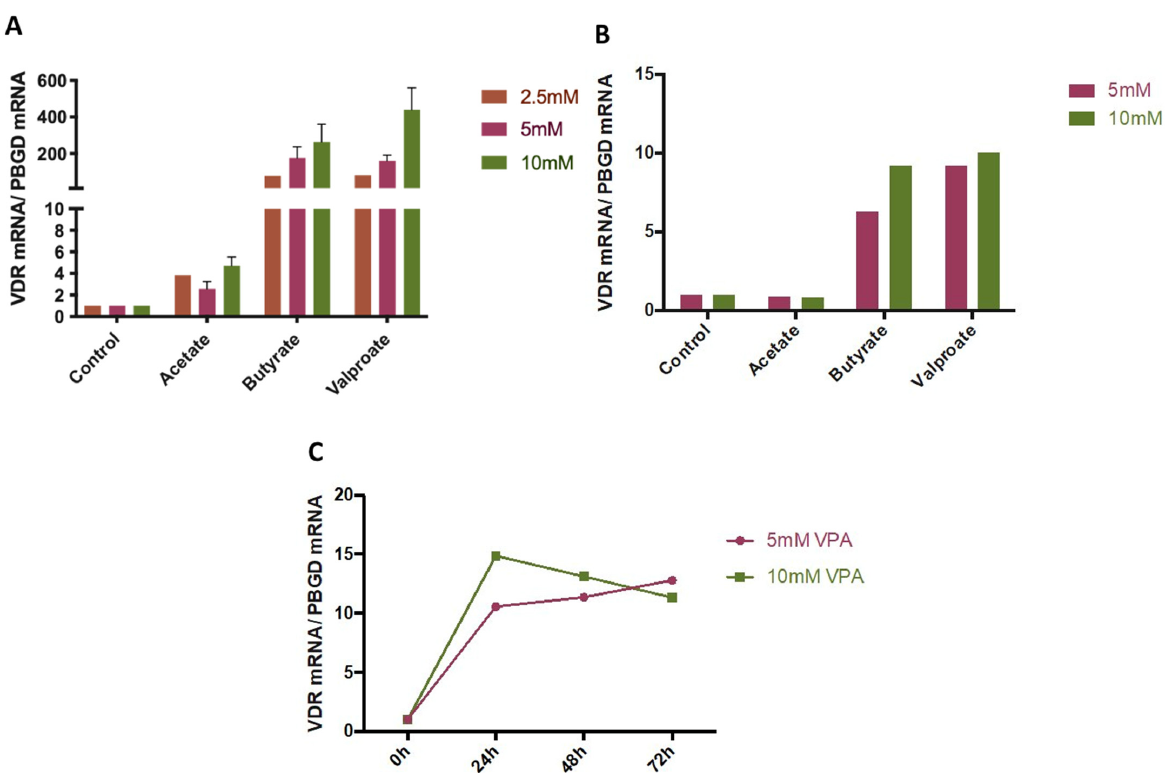
Figure 2. hVDR (human Vitamin D Receptor) mRNA expression levels after treatment with VPA(valproic acid)/SCFAs (short chain fatty acids). HepG2 ( A ) and Upcyte hepatocytes ( B ) were treated with 2.5, 5, and 10 mM of acetate, butyrate, and VPA for 24 h. Extended incubation times (48 h and 72 h) were investigated in Upcyte hepatocytes ( C ). Results are expressed as mean ± SEM from 2–3 independent experiments ( A ) or as average of duplicates from a single experiment (B) and are represented as fold-change relative to vehicle (control) ( A , B ) or to time 0 h ( C ).